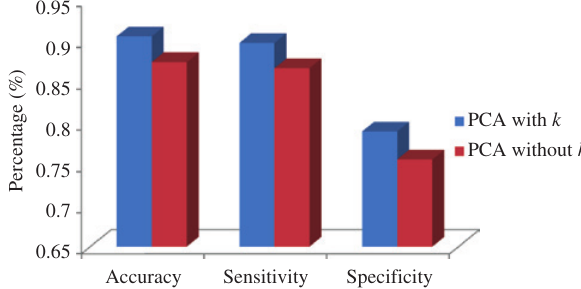
Figure 9: Comparison Results for PCA with and without k Value.